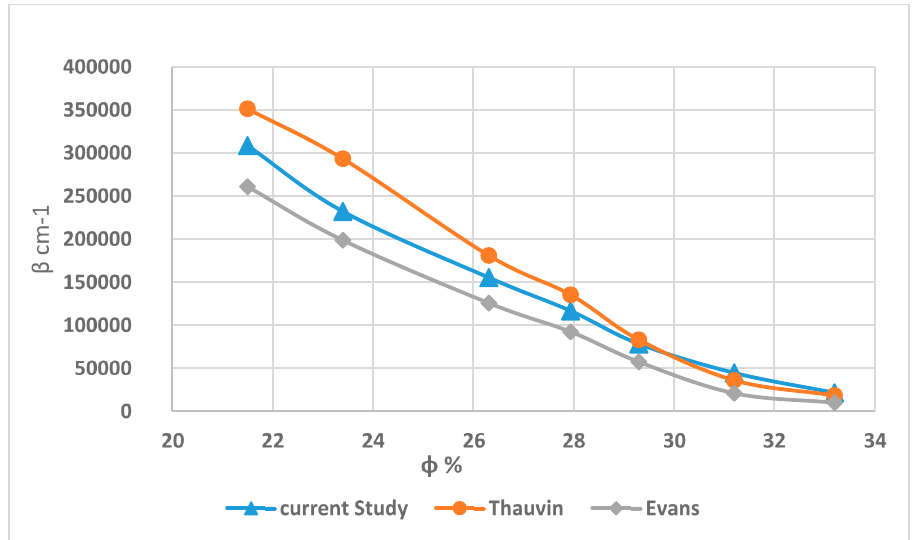
Figure 13. Comparison of correlation equation (23) with Geertsma and Tek correlations.